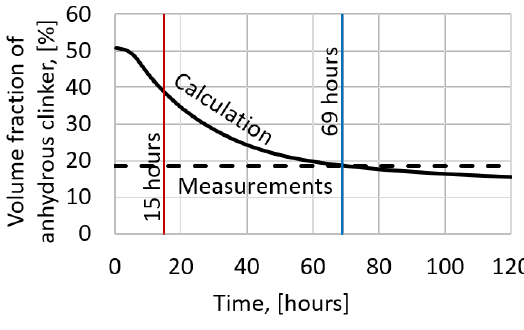
Figure 2. Amount of anhydrous clinker.